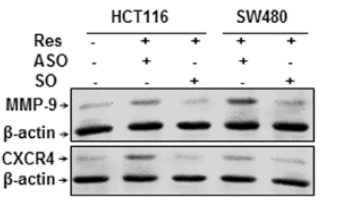
Figure 7. Effects of resveratrol or/and ASO against Sirt1 on NF- κ B-regulated gene products involved in proliferation and metastasis in colorectal cancer cells. Serum-starved HCT116 and SW480 cell lines in alginate culture (1 ˆ 10 6 /mL) were either left untreated or treated as described above (Figure 6). Whole cell lysates were fractionated and subjected to Western blotting with antibodies against MMP-9, CXCR4 and β -actin. Housekeeping protein β -actin served as a loading control in all